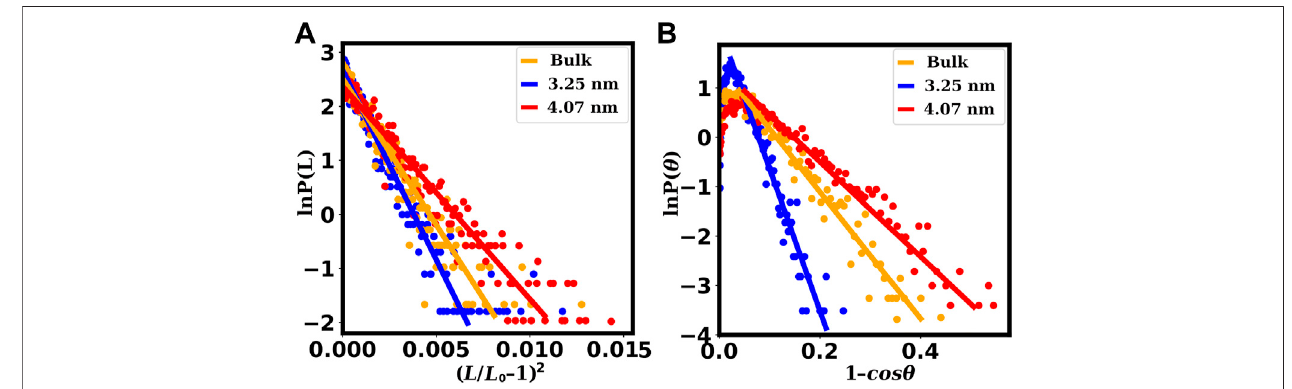
FIGURE 10 | Fits for the computation of stretch moduli and persistence lengths of the dsDNAs con fi ned inside SWCNTs of different chirality indices. The plots (A) forthestretchmoduliareobtained fromthe fi ttingof Eq.4 ,andtheplots (B) forthepersistence lengthsareobtainedfromthe fi ttingof Eq.2 .Thered linescorrespondto chirality indices (30,30) or 4.07 nm diameter, representing dsDNAs con fi ned inside wider SWCNTs. The blue lines correspond to chirality indices (24,24) or 3.25 nm diameter, representing dsDNAs con fi ned inside SWCNTs with intermediate diameters. The orange lines correspond to bulk dsDNA without con fi nement. In the case of dsDNAs con fi ned inside wider SWCNTS, slopes of the linesare signi fi cantly smaller signifying surprisingly low values of the stretch modulus and the persistence